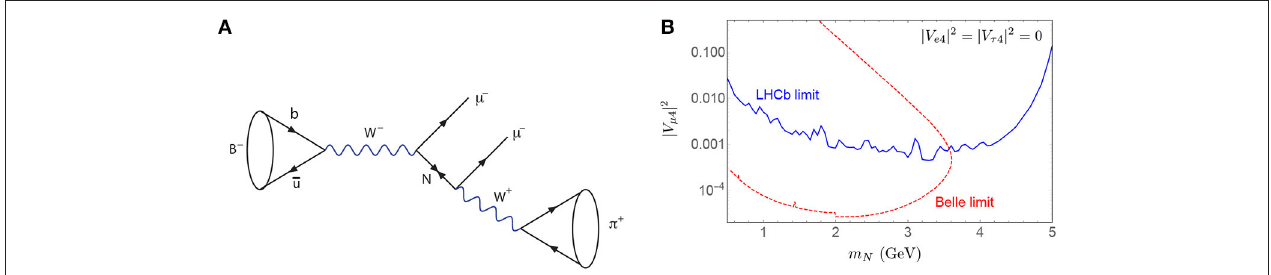
2 (labeled 2 in the figure) as a function V µ N V µ 4 | | | |